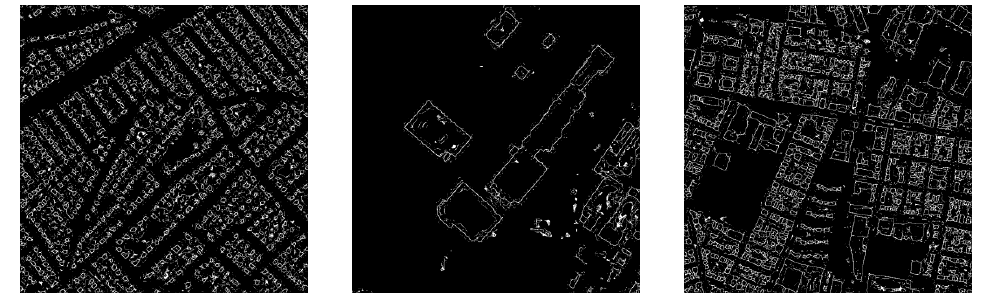
Figure 5. The refinement results by NMS algorithm.